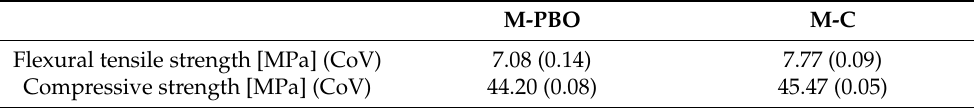
Table 2. Mechanical properties of the matrix.